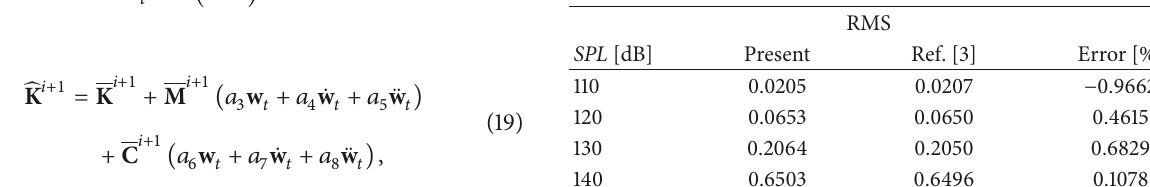
Table 2: Validation of random acoustic load